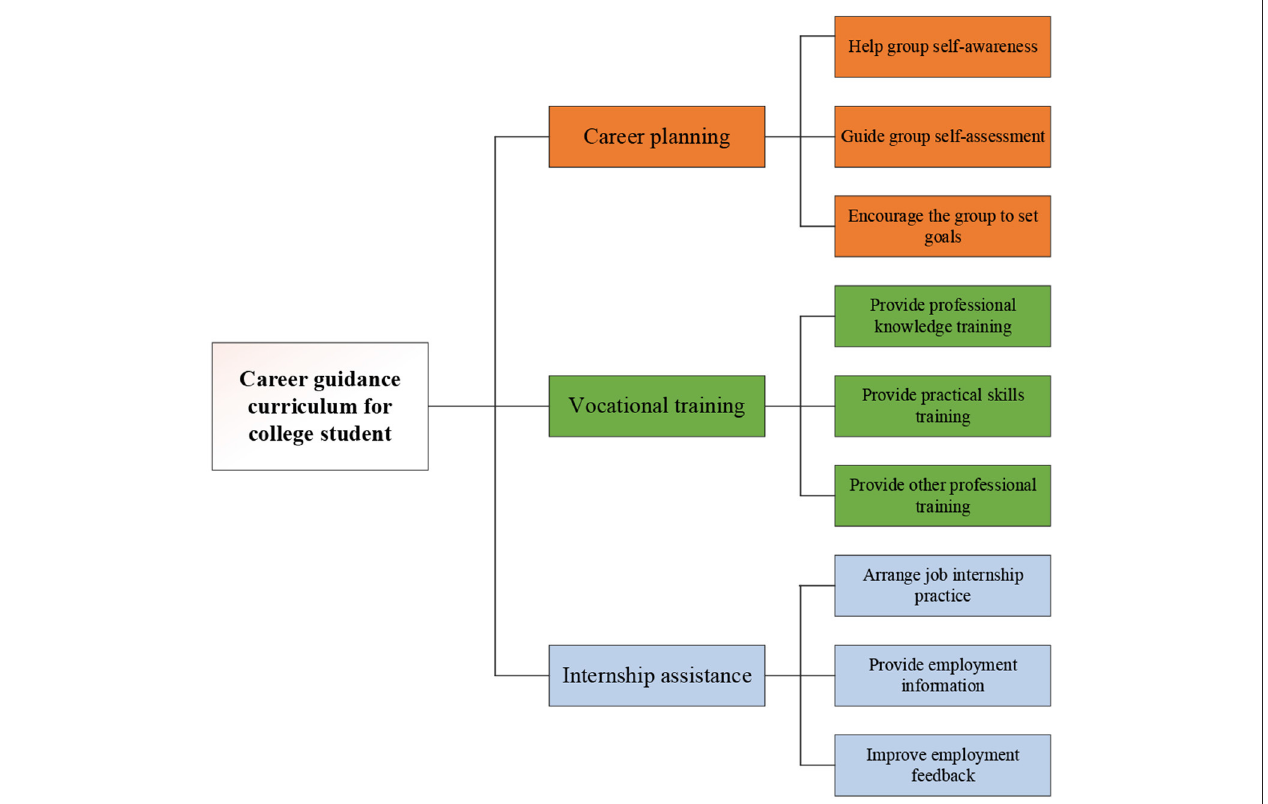
FIGURE 1 | Structure of career guidance curriculum for college students.